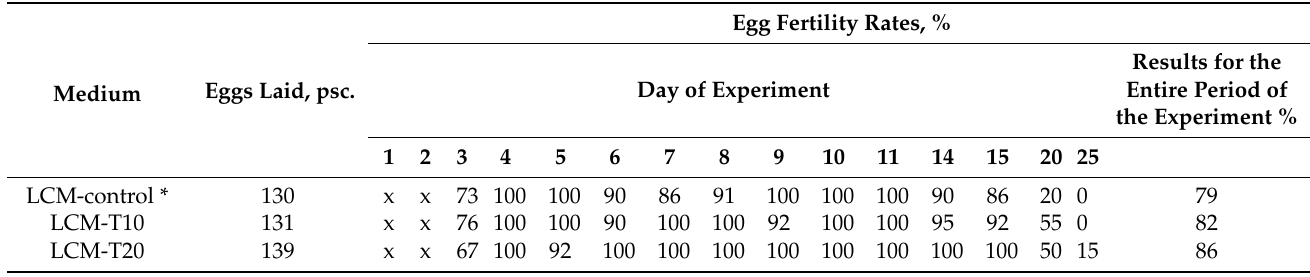
Egg Fertility Rates, % Day of Experiment